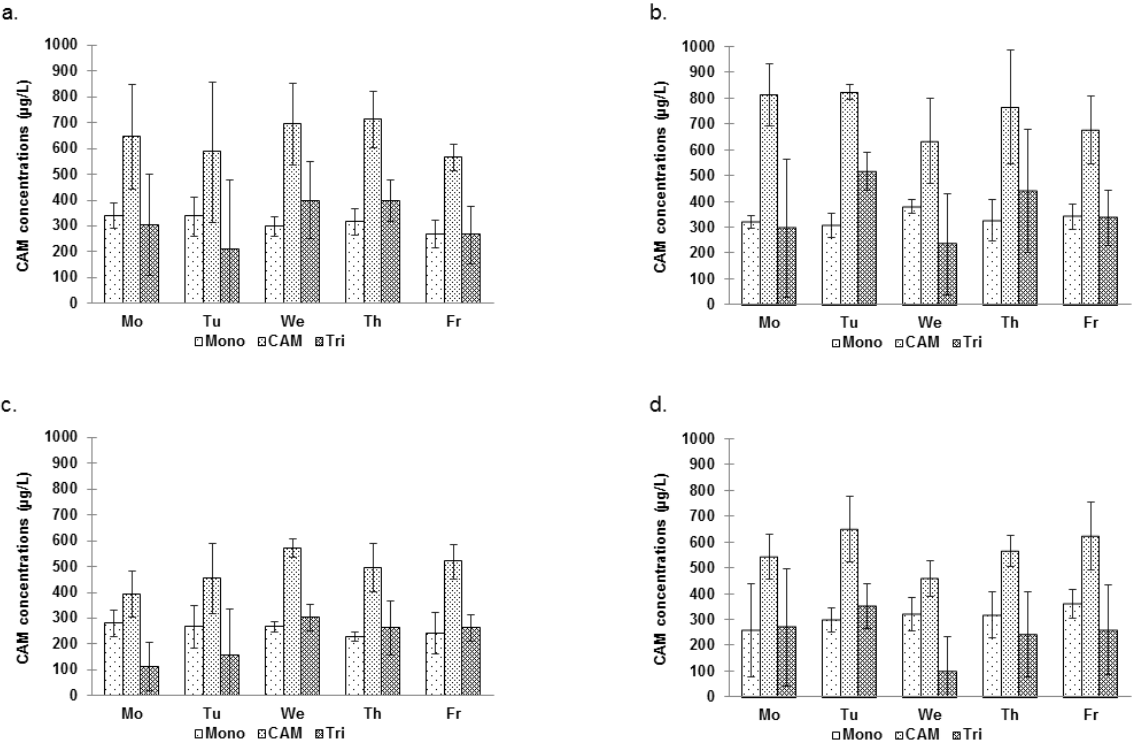
Figure 3. Mean daily concentrations of MCAM (Mono), TCAM (Tri) and Total CAM in water in [A] and [B] during S1 and S2. ( a ) [A]–S1; ( b ) [A]–S2; ( c ) [B]–S1; ( d )